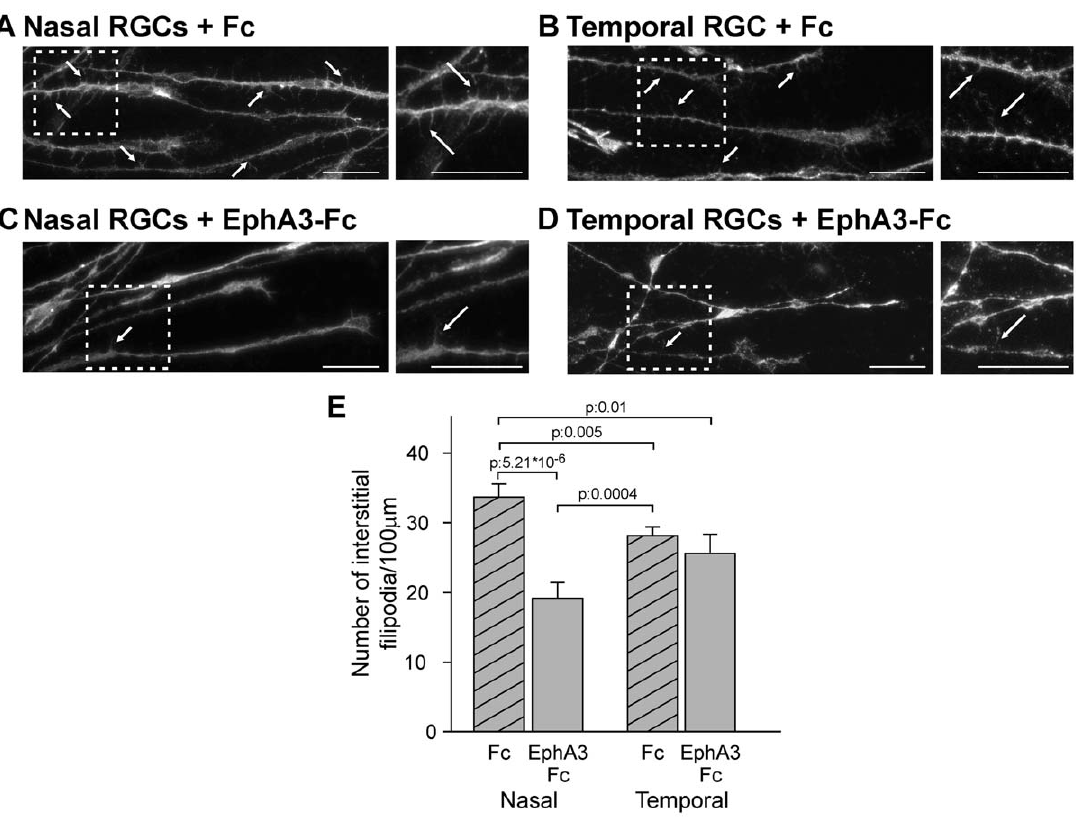
Figure 5. EphA3 ectodomain decreases the density of interstitial filopodia in nasal RGC axons. A–D. Representative microphotographs of axons grown from nasal (A, C) and temporal (B, D) retinal explants exposed to soluble clustered Fc (A, B) or EphA3-Fc (C, D). Axons are labeled with Alexa 488-phalloidin. Arrows depict representative interstitial filopodia. Insets show filopodia at higher magnification. Scale bars =20 m m. (E) Quantification of filopodia number/100 m m of axon shafts. Nasal axons present higher density of interstitial filopodia and EphA3-Fc significantly decreases the density of interstitial filopodia in nasal RGC (ANOVA and Tukey postest, 3 experiments, n: 8 axons for explant, 4 explants for condition). Results are shown as mean + / 2 SE.